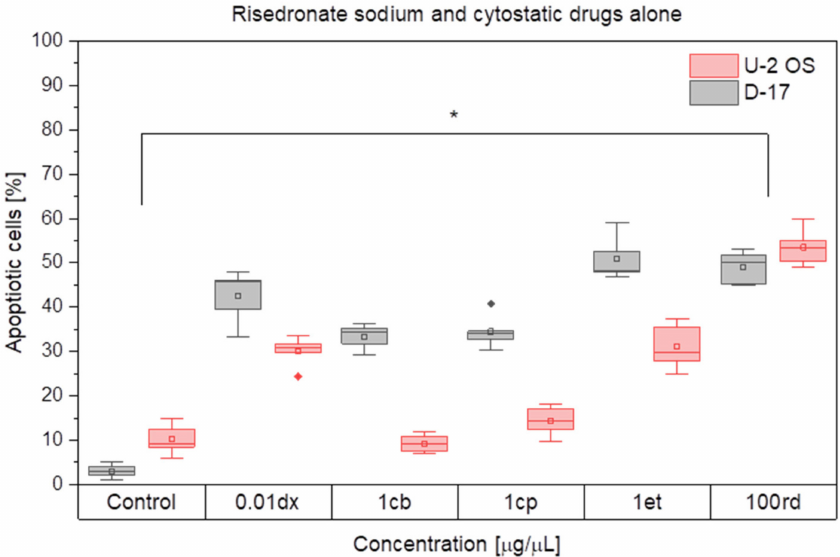
Figure 3. The effect of cytostatic drugs and risedronate sodium per se on the cell apoptosis in the canine and human osteosarcoma cell lines. dx—doxorubicin, cp—cisplatin, cb—carboplatin, et—etoposide, rd—risedronate sodium, rhombus—outliers, * ( p <